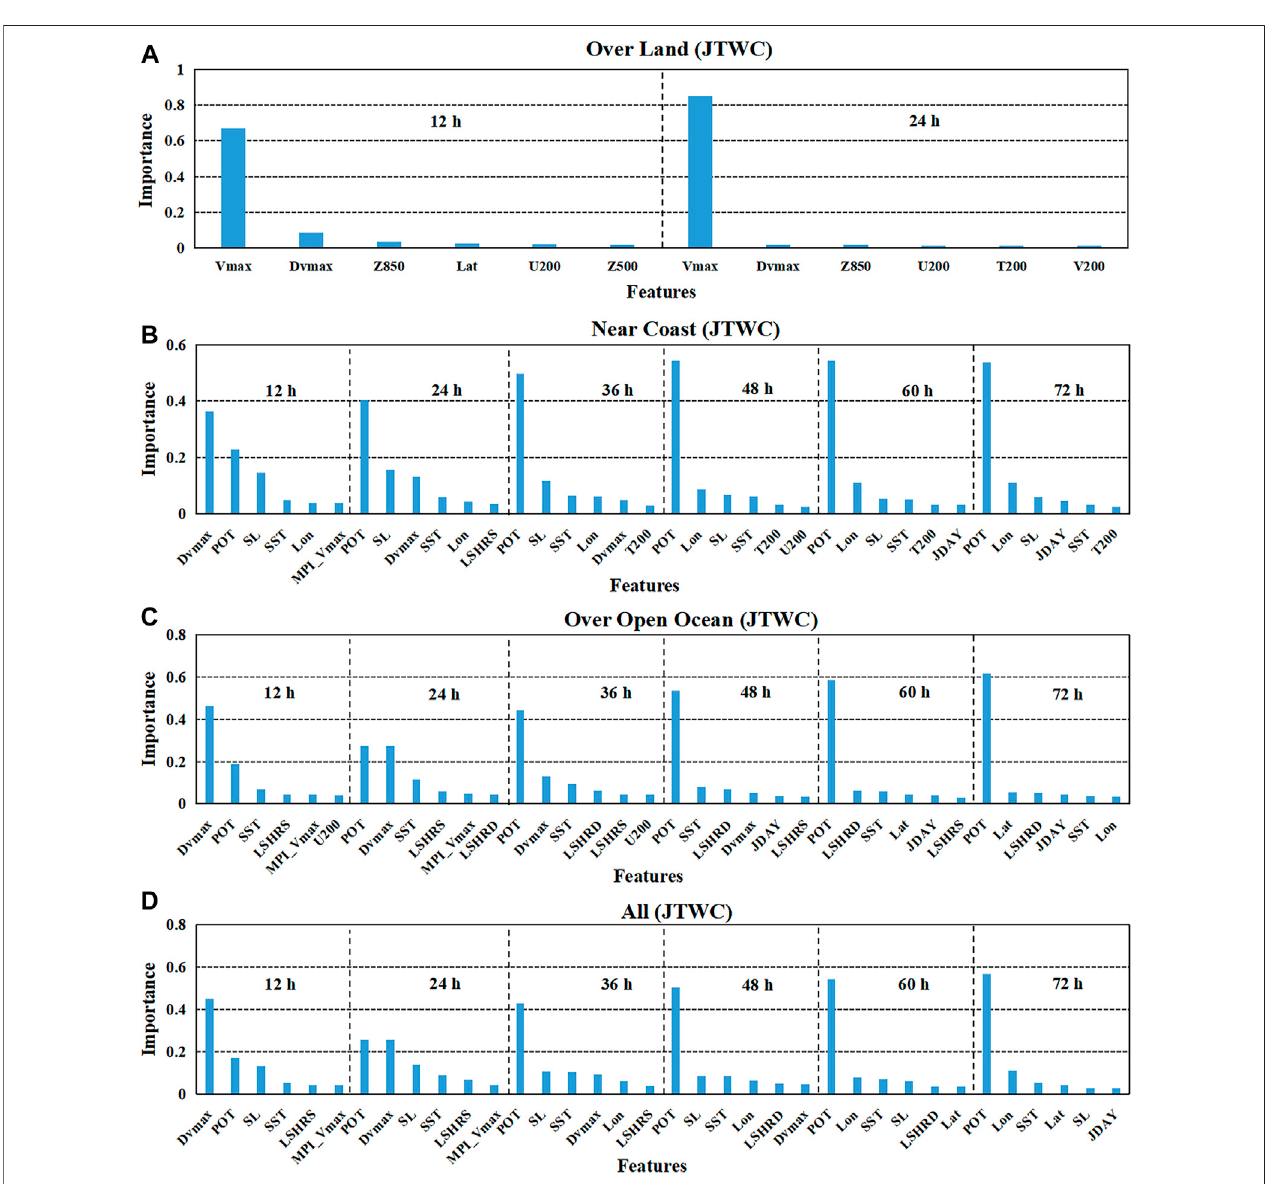
FIGURE3| Selectionresultsofthesigni fi cantvariablesforTCsintensitypredictionmodelsfortheJTWCdatasetsbytheGBRTmethod.Theverticalaxisrepresents the percentage of the feature importance of the variable in the corresponding prediction model, and the horizontal axis refers to the predictor variable. Only the six most importantvariablesaredisplayedforeachleadtimeforecastingmodel. (A) forTCsamplesoverland; (B) forTCsamplesnearthecoast; (C) forTCsamplesovertheopen ocean; (D) for all TC samples.